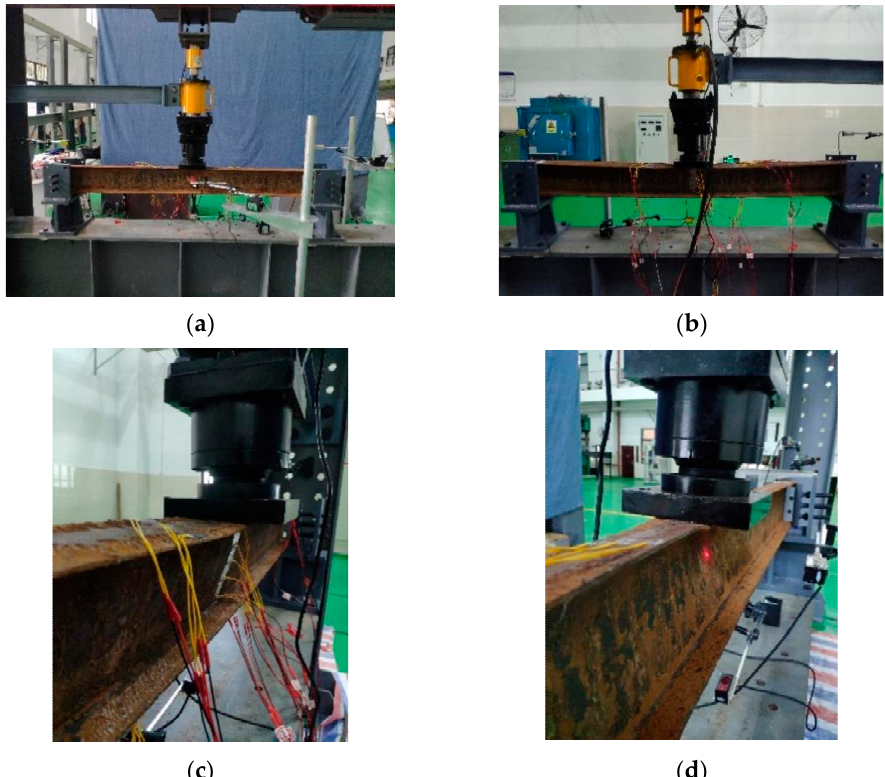
Figure 10. Failure mode of the steel beam: ( a ) Before testing; ( b ) After testing; ( c ) After testing; ( d ) After testing.